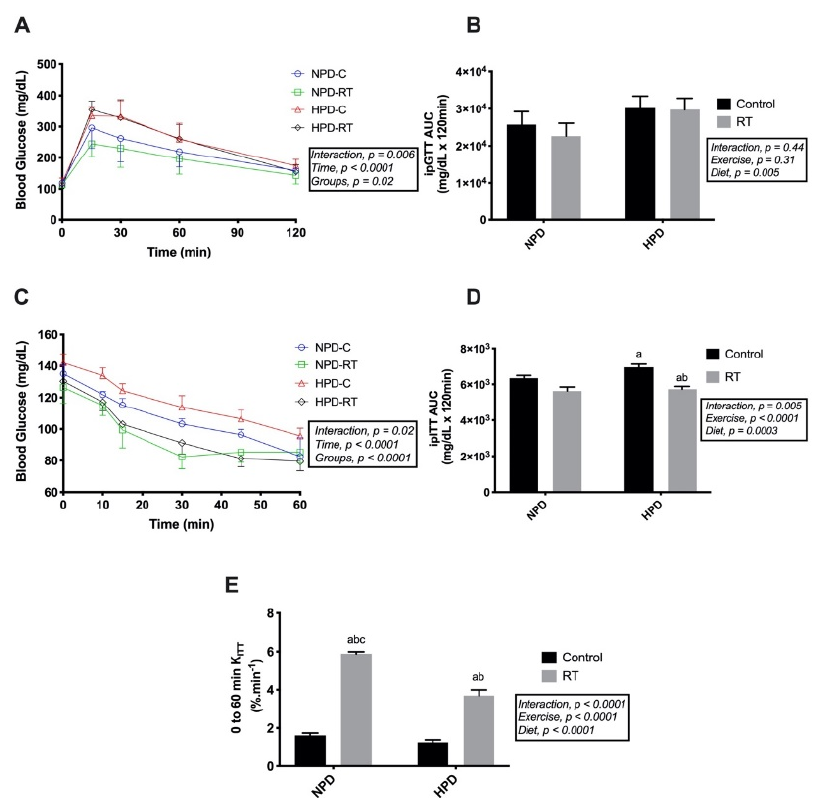
Figure 2. Whole-body glucose and insulin tolerance tests. ( A ) Blood glucose values throughout